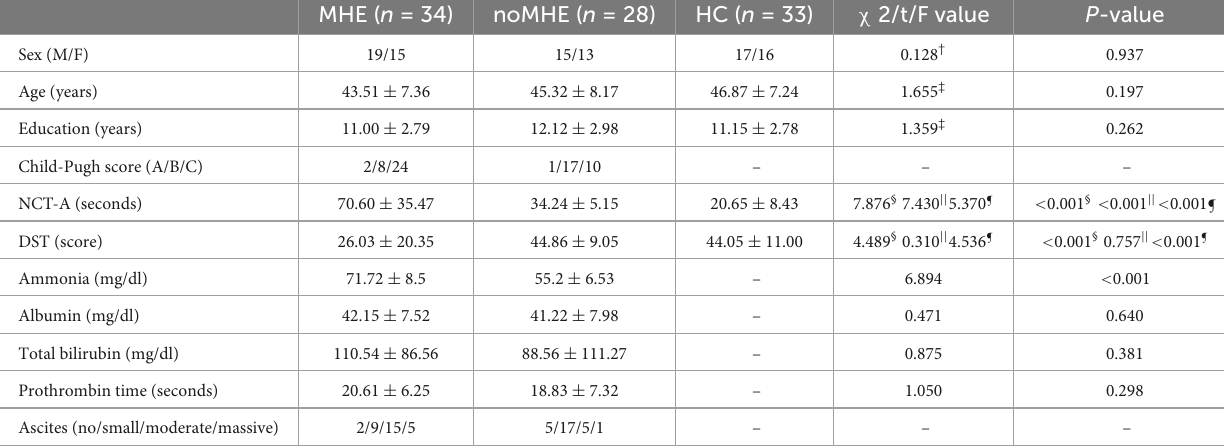
TABLE 1 Comparison of clinical data among subjects in the two groups.